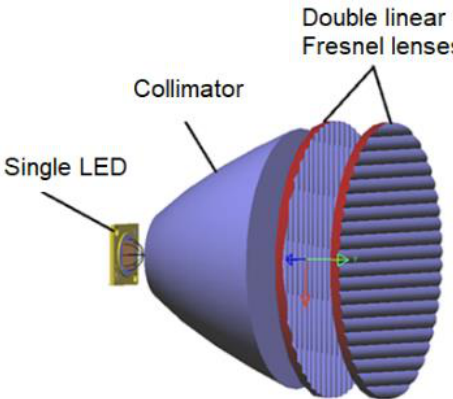
Figure 2. Structure of LED illumination system composed of an LED chip, collimator, and double linear Fresnel lenses.